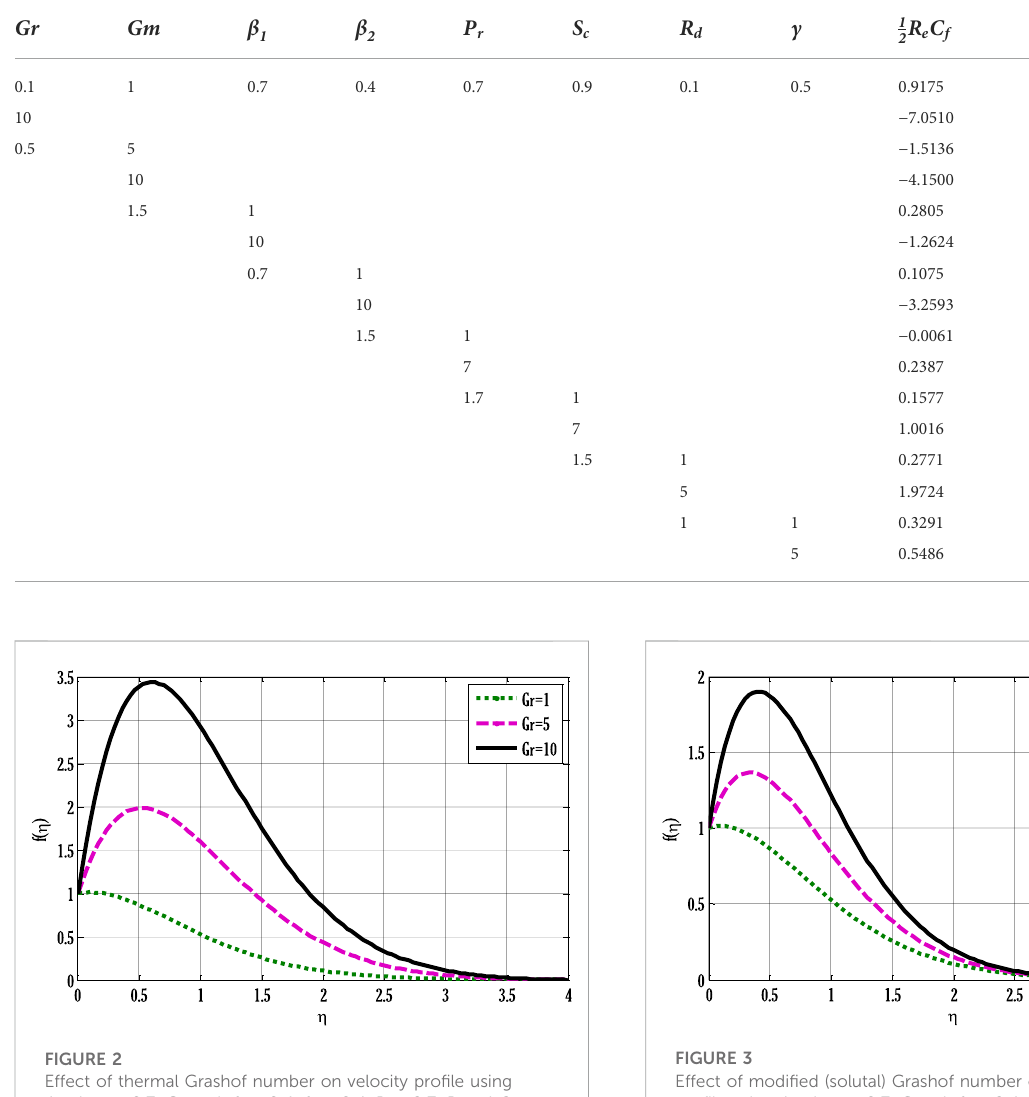
FIGURE 2 Effect of thermal Grashof number on velocity pro fi le using A (cid:1) 1 , v 0 (cid:1) 0 . 7 , Gm (cid:1) 1 , β 0 . 9 , γ (cid:1) 0 . 7 , N (cid:1) 120 .